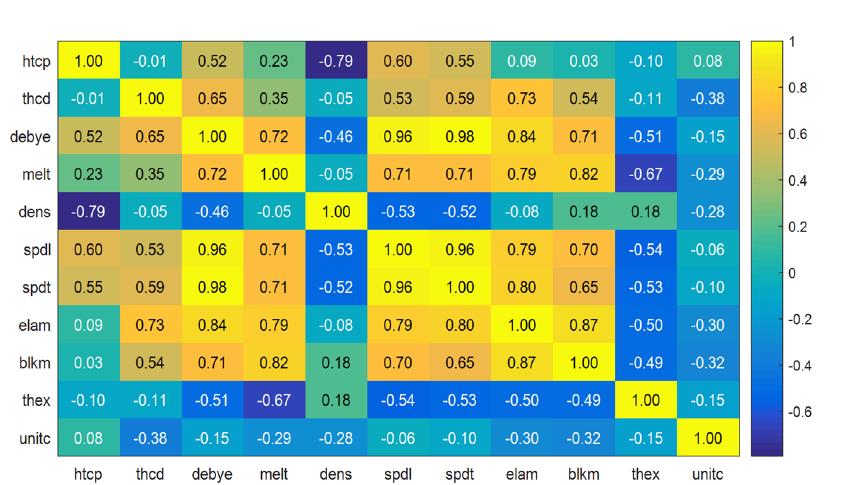
Figure 4. Pearson correlation coefficient map between different materials properties. htcp (heat capacity), thcd (thermal conductivity), debye (Debye temperature), melt (melting point), dens (density), spdl (speed of sound longitudinal), spdt (speed of sound transverse), elam (elastic modulus), blkm (bulk modulus), thex (thermal expansion coefficient), and unitc (unit cell